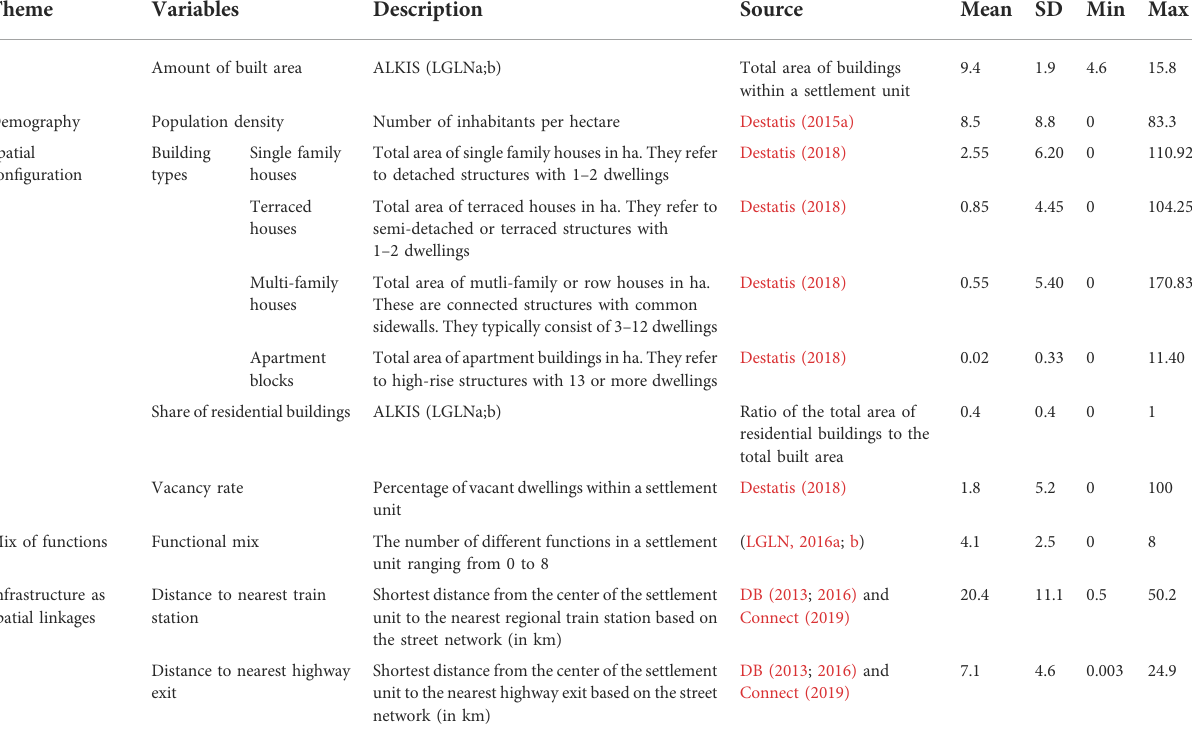
TABLE 1 Characteristics of the TOPOI under study (n =